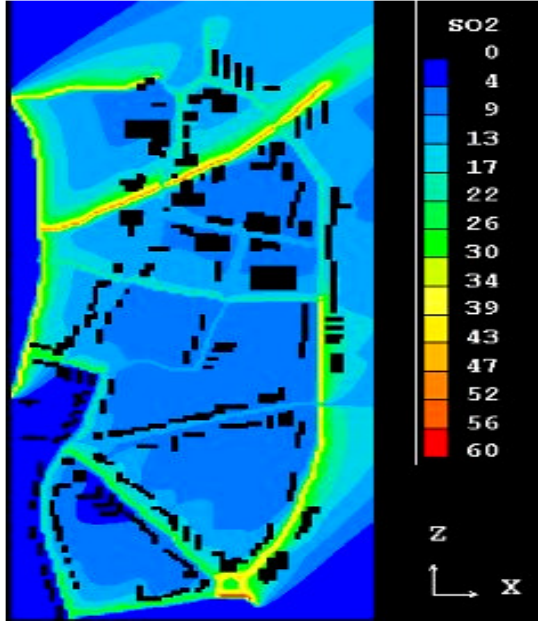
Fig 10. The modelling results of scatter of SO 2 (SO 2 ) con- 3 ) in Žirmūnai when the wind blows from centration ( µ g/m the southwest at 5 m/s speed